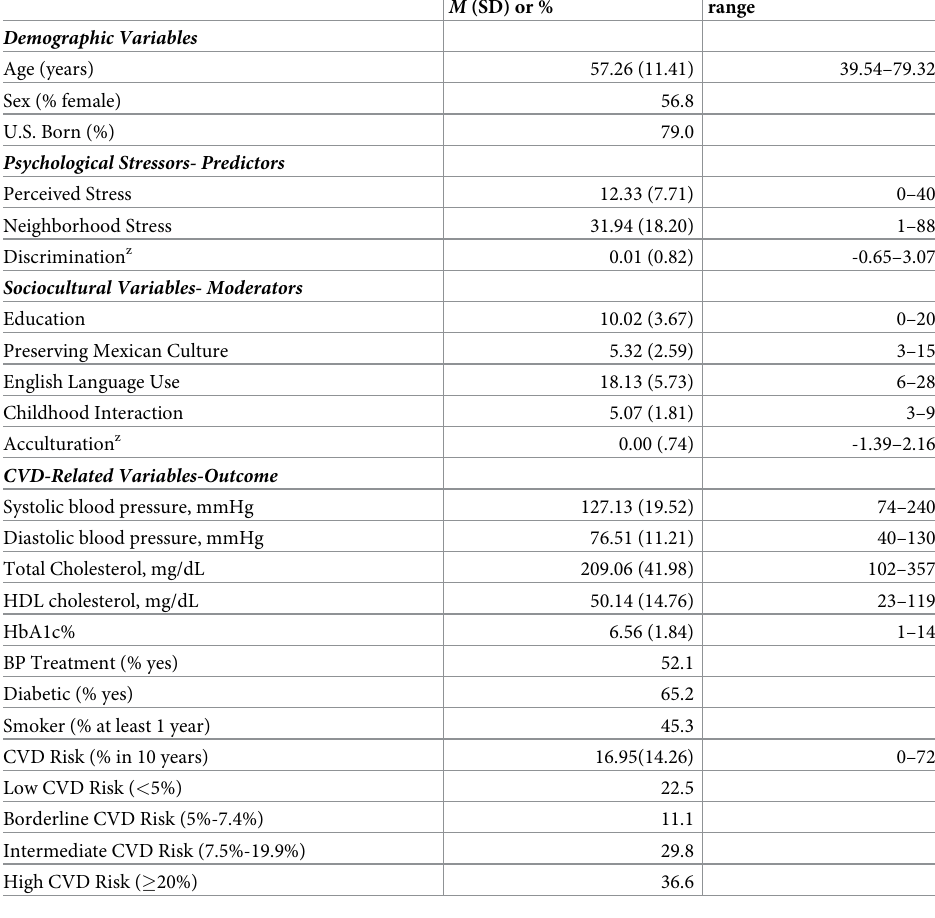
Table 1. Participant demographic, psychological stressors, sociocultural, and cardiovascular risk factor character- istics ( n =